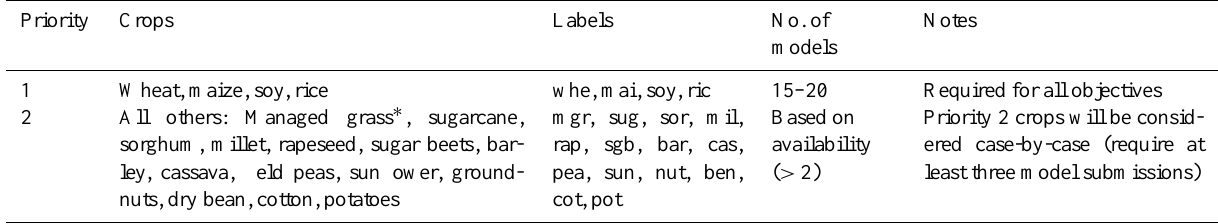
Table 2. Priority 1 and 2 crops in Phase 1, along with the number of models expected to contribute results for each crop.